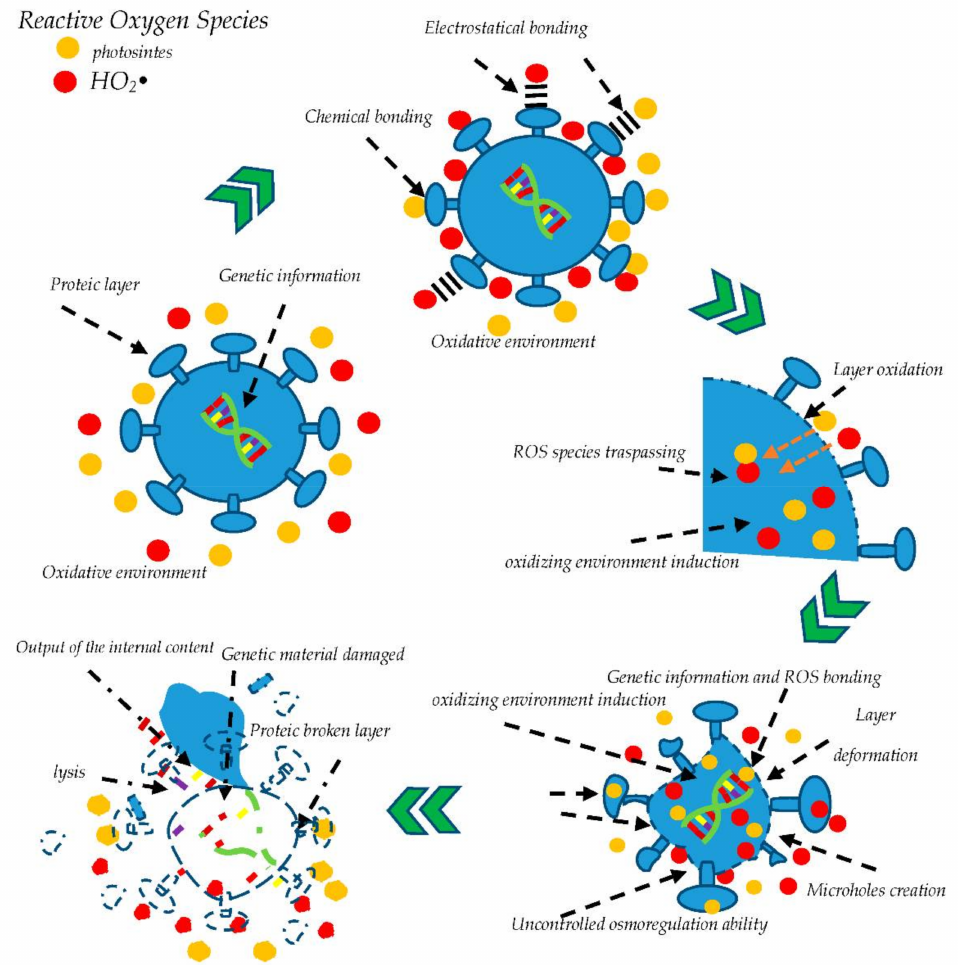
Figure 1. Disinfection mechanism purposed for virus using TiO 2 [45,72,74,75]. In addition, ref. [33] points out that the possible contact between the organism